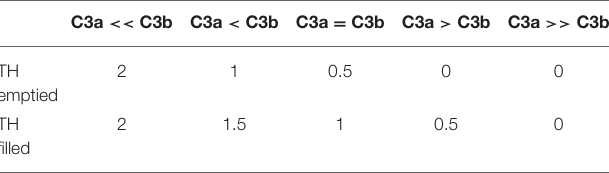
TABLE 4 | Evaluation of the criterion C3, based on the medial positioning of the hippocampus in a coronal